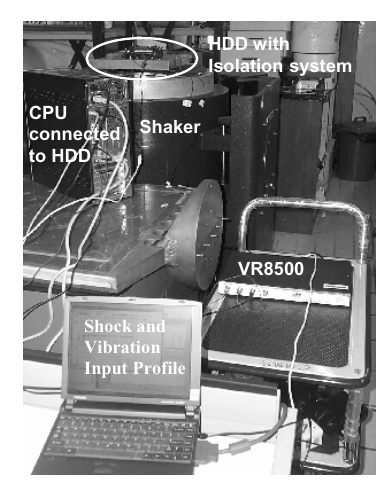
Fig. 3. Experiment set up for vertical random